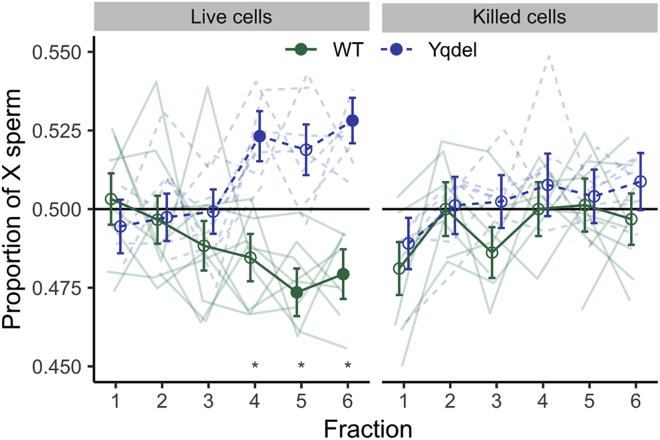
Motility Testing Shows Y-Bearing Sperm Are Poorer Swimmers Than X-Bearing in Yq-del MalesThe x axis indicates sperm fractions with relatively increasing motility. Highly motile sperm are enriched for X-bearing over Y-bearing sperm in Yqdel samples but the reverse in wild-type samples. The negative control (freeze-/thaw-killed sperm) showed no enrichment for X or Y sperm in any fraction. Individual samples are shown in faded lines. Stronger lines show the means and SEs of proportion per fraction per genotype. Closed symbols indicate fractions that were individually different from a 50:50 ratio; open symbols indicate fractions that are not significantly different from 50:50 (one sample Z-test; p < 0.05 after Bonferroni-Holm multiple testing correction). ∗ indicates fractions where the difference between Yqdel and WT genotypes is significant (two sample Z-test; p < 0.05 after Bonferroni-Holm multiple testing correction). Full data on regression parameters are given in Table S4. See also Figure S4.